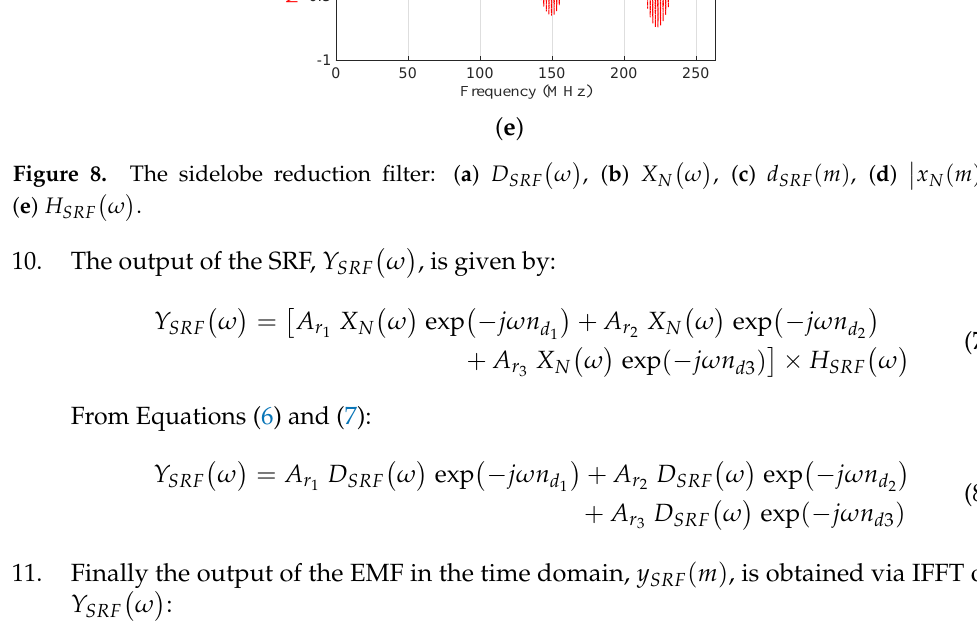
(cid:0) (cid:1) ω , ( c ) d SRF ( m ) , ( d )